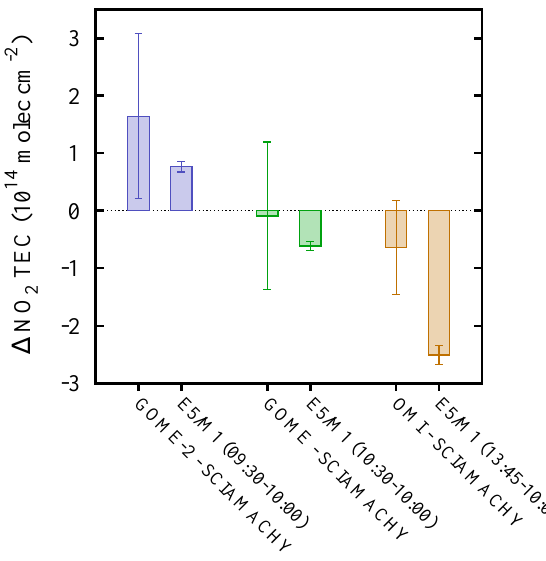
Fig. 6. Difference in mean NO 2 TEC ( ∆NO 2 TEC) as a result of diurnal variation in tropospheric NO 2 over the region S estimated from satellite measurements compared to the corresponding ∆NO 2 TEC from model simulations. The differences in NO 2 TEC between GOME-2 (09:30 a.m.) and SCIAMACHY (10:00 a.m.) measurements are calculated for the period from March 2007 to February 2008, the differences in NO 2 TEC between GOME (10:30 a.m.) and SCIAMACHY (10:00 a.m.) measurements are calculated for the period from August 2002 to June 2003 and the differences in NO 2 TEC between OMI (13:45 a.m.) and SCIAMACHY (10:00 a.m.) measurements are calculated for the period from October 2004 to February 2008. The error bar for the model simulations shows the interannual standard deviation.